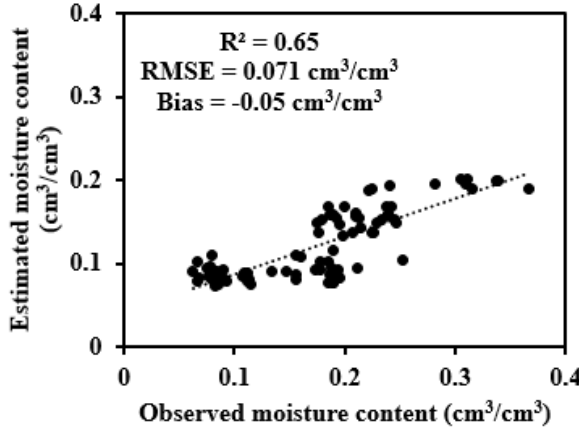
Figure 4. Scatter plot of observed soil moisture, at the soil moisture measurement sites in the Reynolds Creek Experimental Watershed, with SERVES estimated soil moisture in the growing season (June through September) of the years 2006 through 2009.